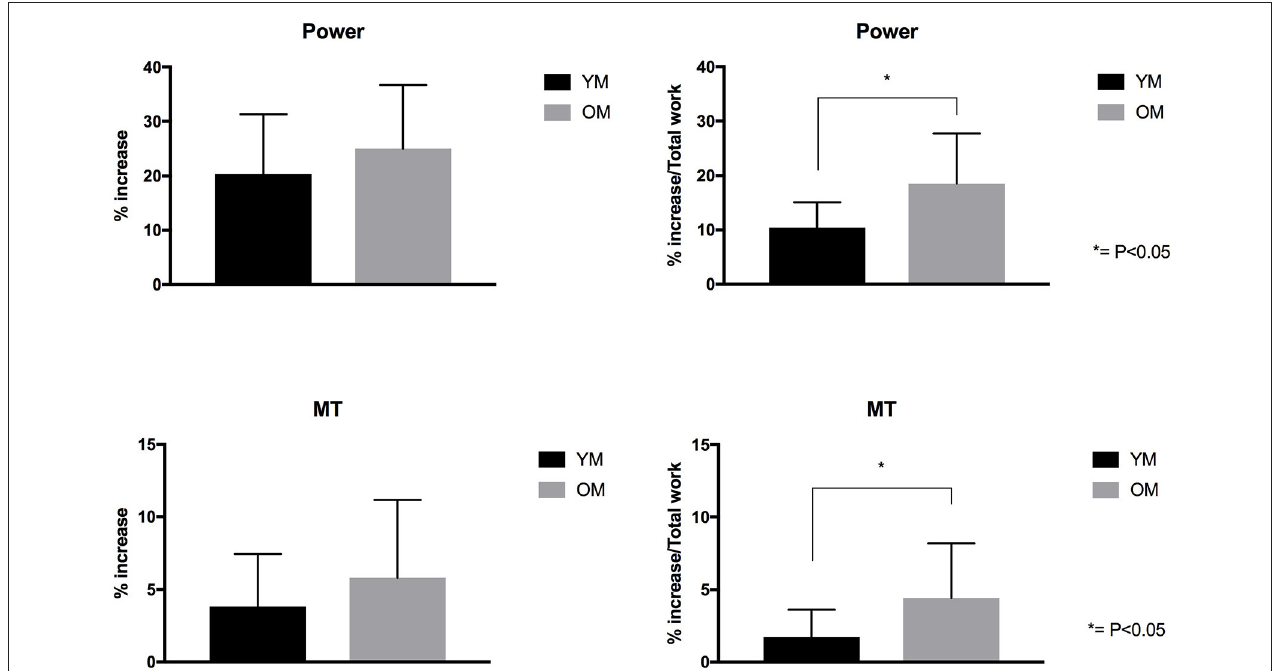
FIGURE 4 | Power and MT% increase for YM and OM groups. On the right side of the figure, Power and MT expressed by Total External Mechanical Work